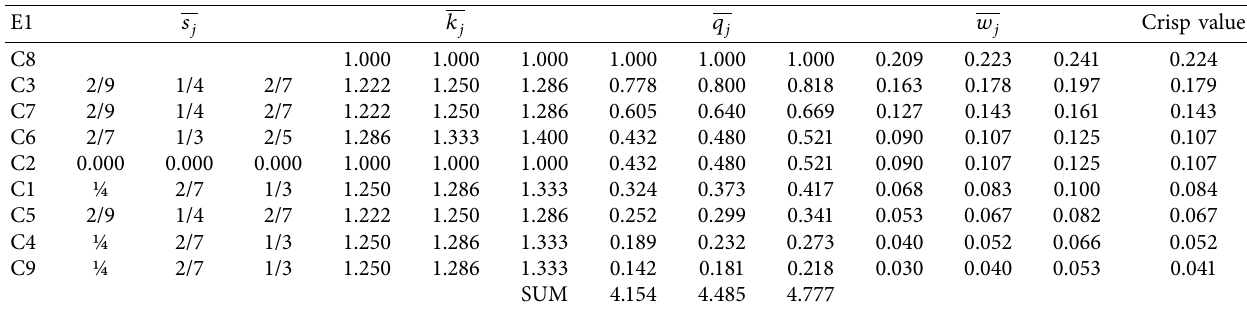
Table 3: Calculation and values of weight coefficients obtained by the IMF SWARA method for the first expert